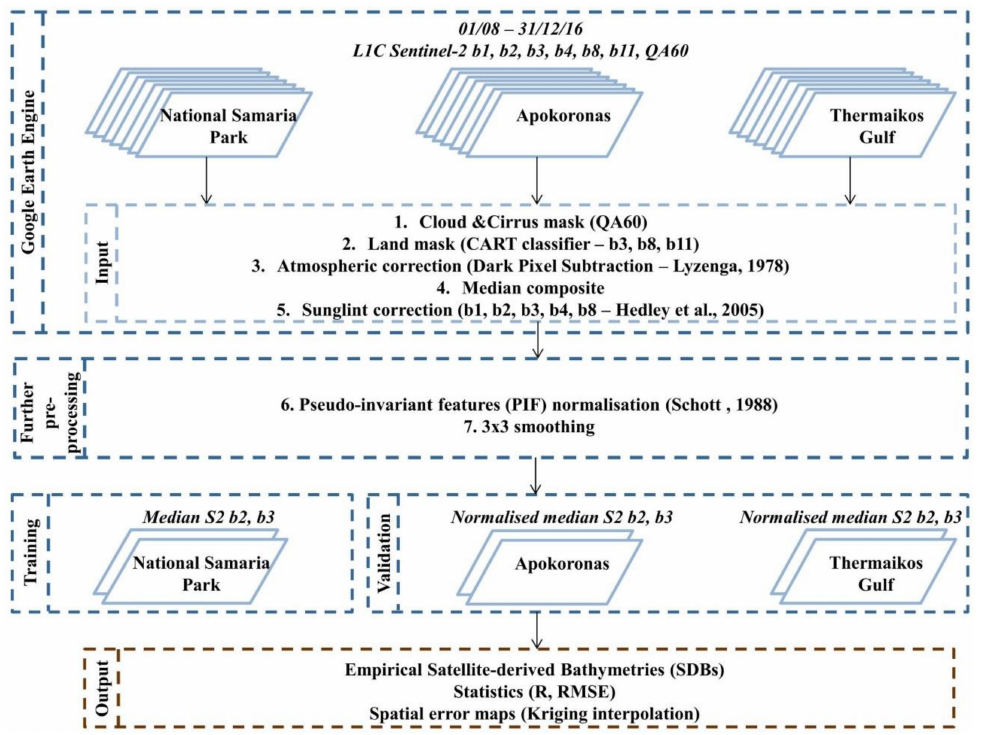
Figure 2. The methodological workflow of the present study. We employ seagrass and algae beds as dark features and shallow sand as bright features; We perform the training of the satellite-derived models in the National Samaria Park sites using two different depth ranges to capture the representative depth range in the validation sites: 0–25 m in Apokoronas and 0–12 m in Thermaikos.